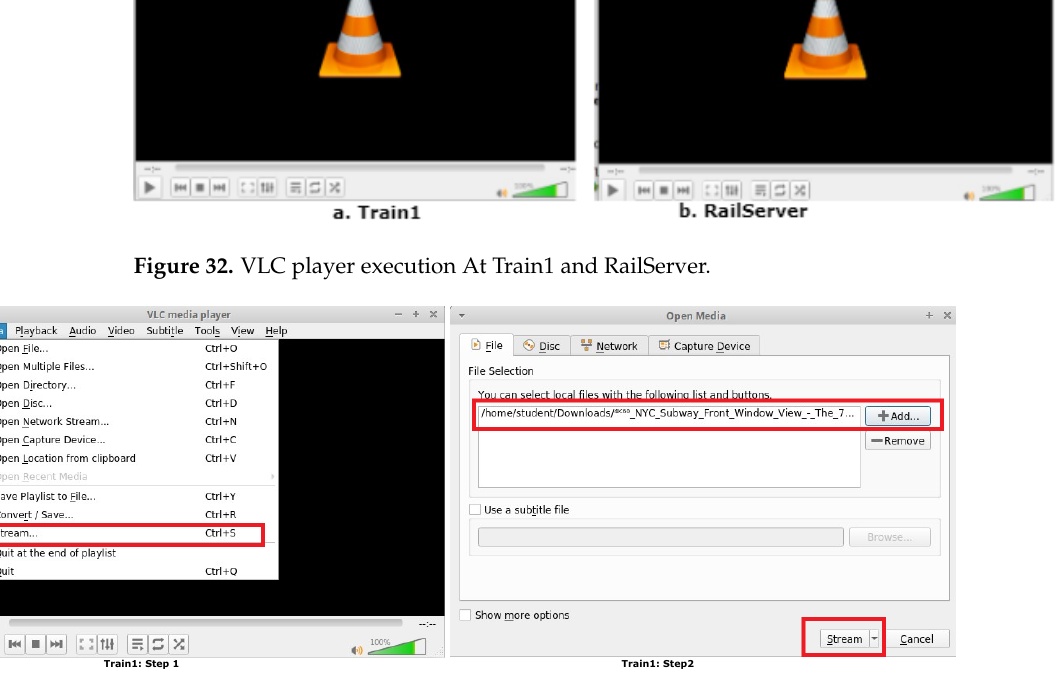
Figure 33. Train1: adding the video file to